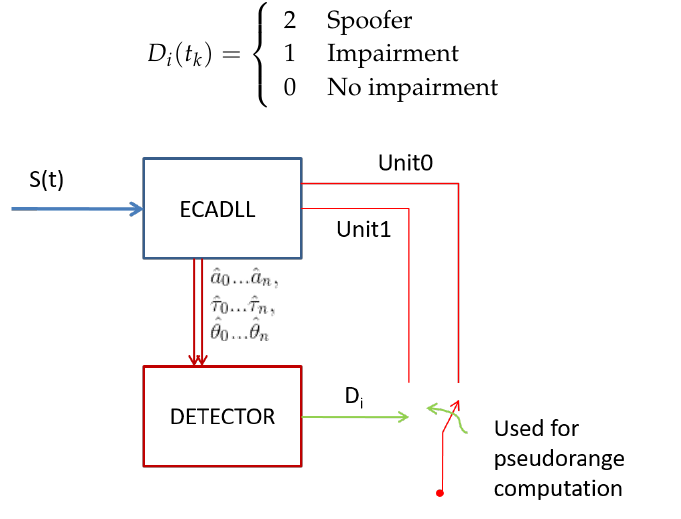
Figure 4. Decision making block